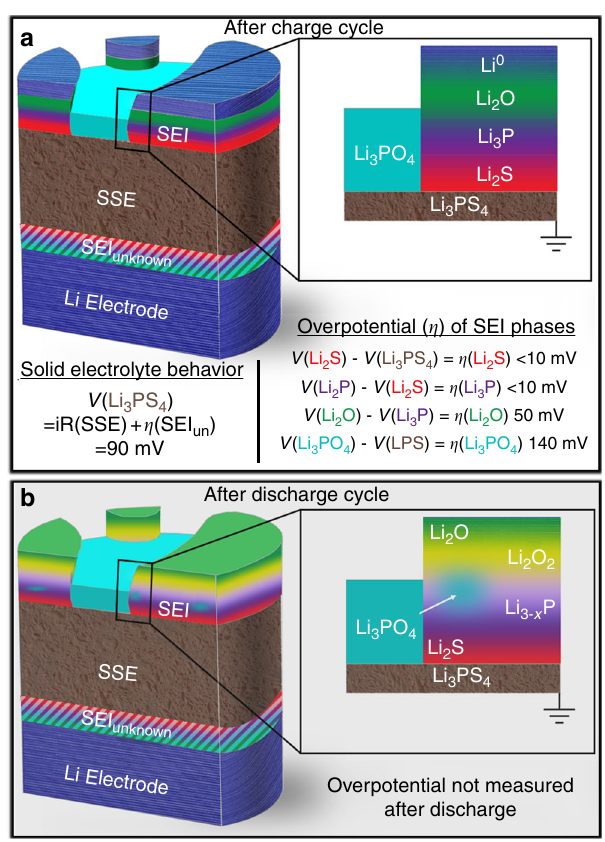
Fig. 7 Summary of SEI composition and morphology. A schematic is shown of the three-dimensional SEI structure after the charge ( a ) and discharge ( b ) step. A summary of the individual SEI overpotentials measured after the charging step is shown in ( a